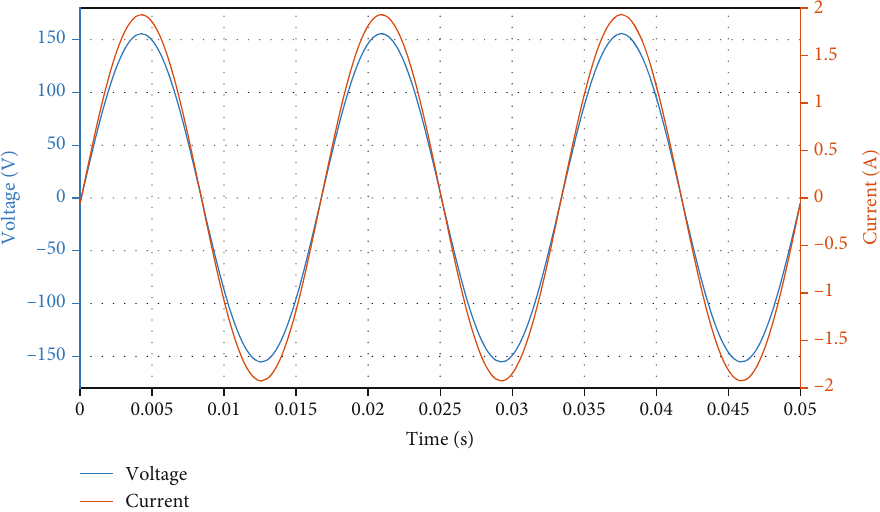
Figure 12: Linear load simulation result. V